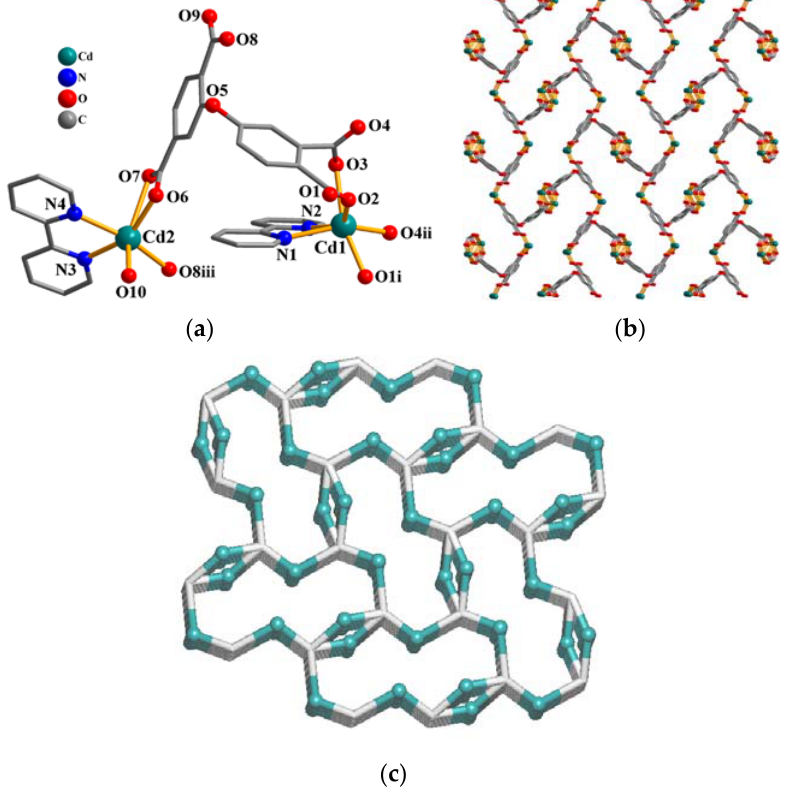
Figure 2. Representations of the structure of 2 . ( a ) Coordination environment and connectivity of Cd atoms. ( b ) Three-dimensional (3D) coordination polymer structure (view along the a axis). ( c ) Topological view of a simplified 3D network representing a two-nodal 3,5-c net of the 3,5T1 topological type. View along the a axis; 2-c Cd2 linkers and 3-c Cd1 nodes (balls, turquoise), centroids of 5-c μ 5 ‐ deta 4– nodes (gray sticks).